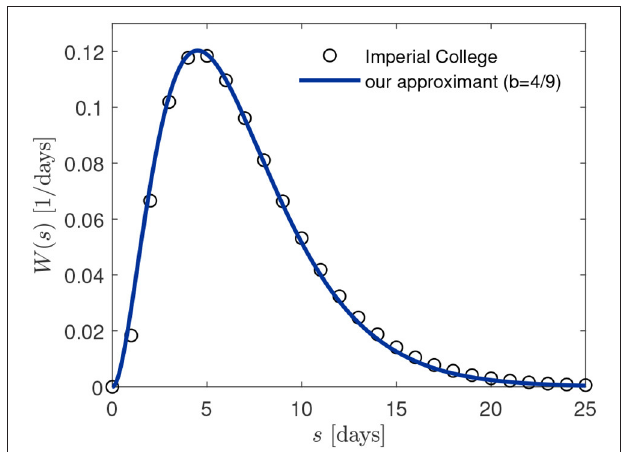
FIGURE 3 | Comparison of serial interval distribution W ( s ) employed in [11, 12] (black circles) and our approximant (27) with b